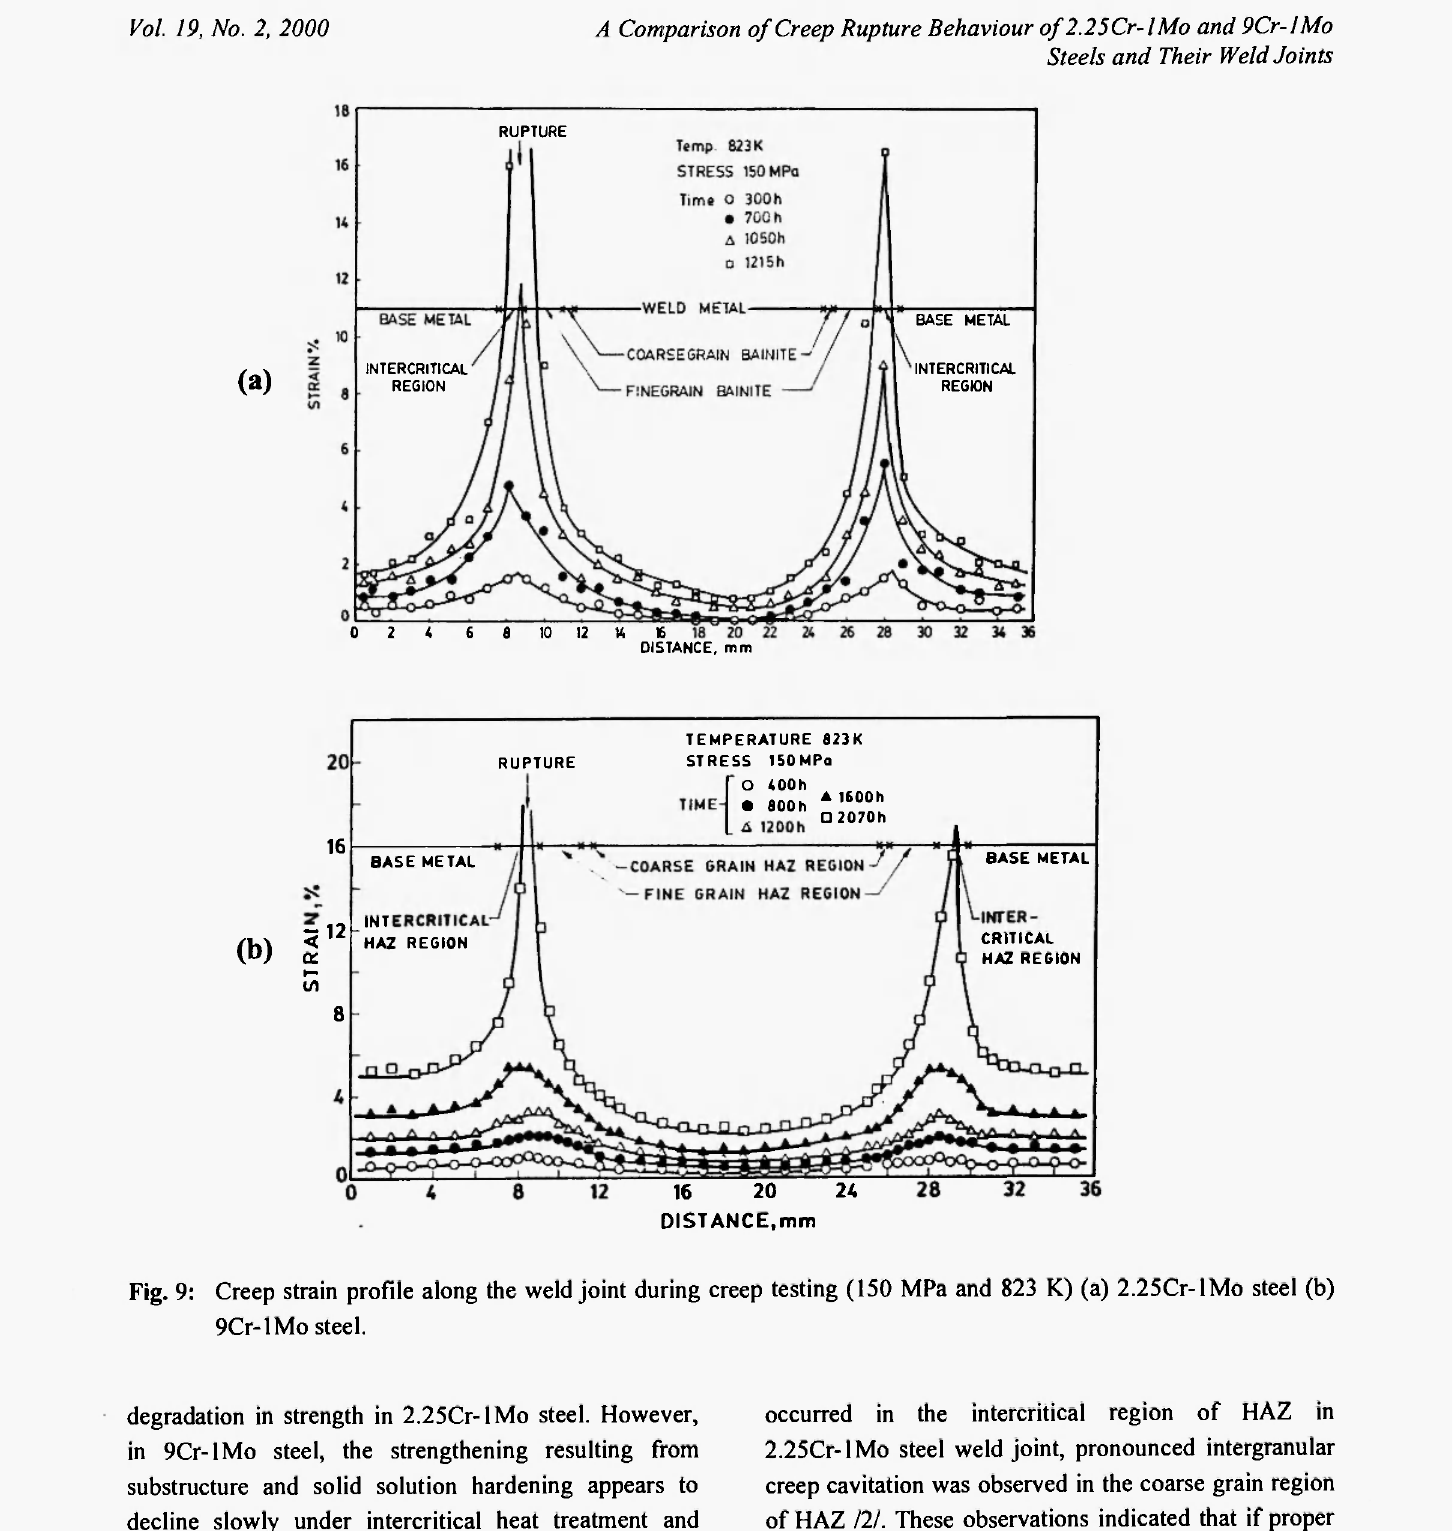
Fig. 9: Creep strain profile along the weld joint during creep testing (150 MPa and 823 K) (a) 2.25Cr-lMo steel (b) 9Cr-lMo